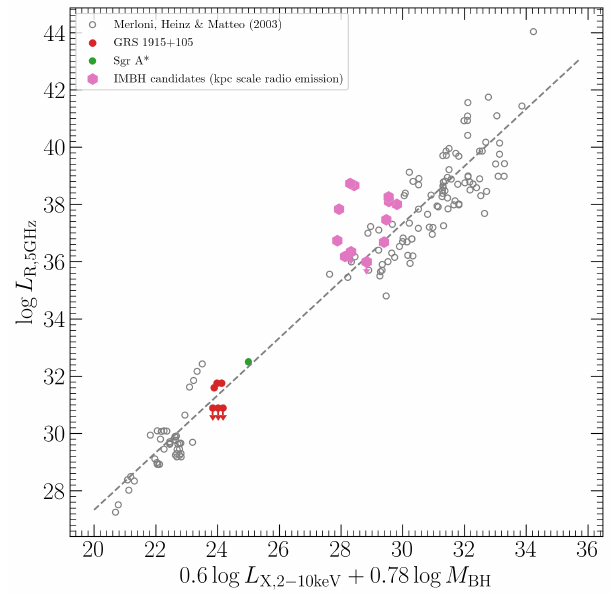
Figure 2. The fundamental plane relation of black hole activity with the kpc scale radio luminosity of IMBH candidates. The radio luminosity from the kpc scale is clearly overestimated with regard to the fundamental